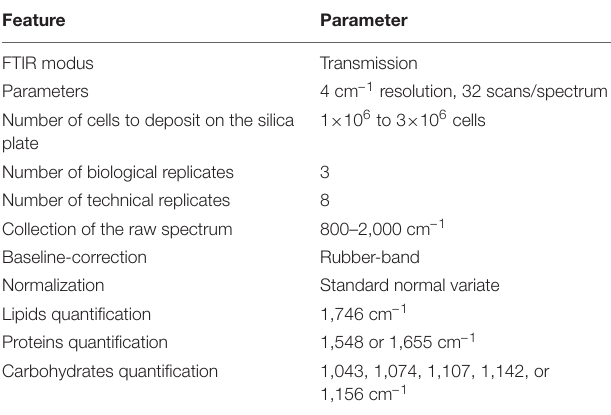
TABLE 3 | Rules to follow for a suitable quantification of lipids, proteins and carbohydrates in P. tricornutum through the described FTIR